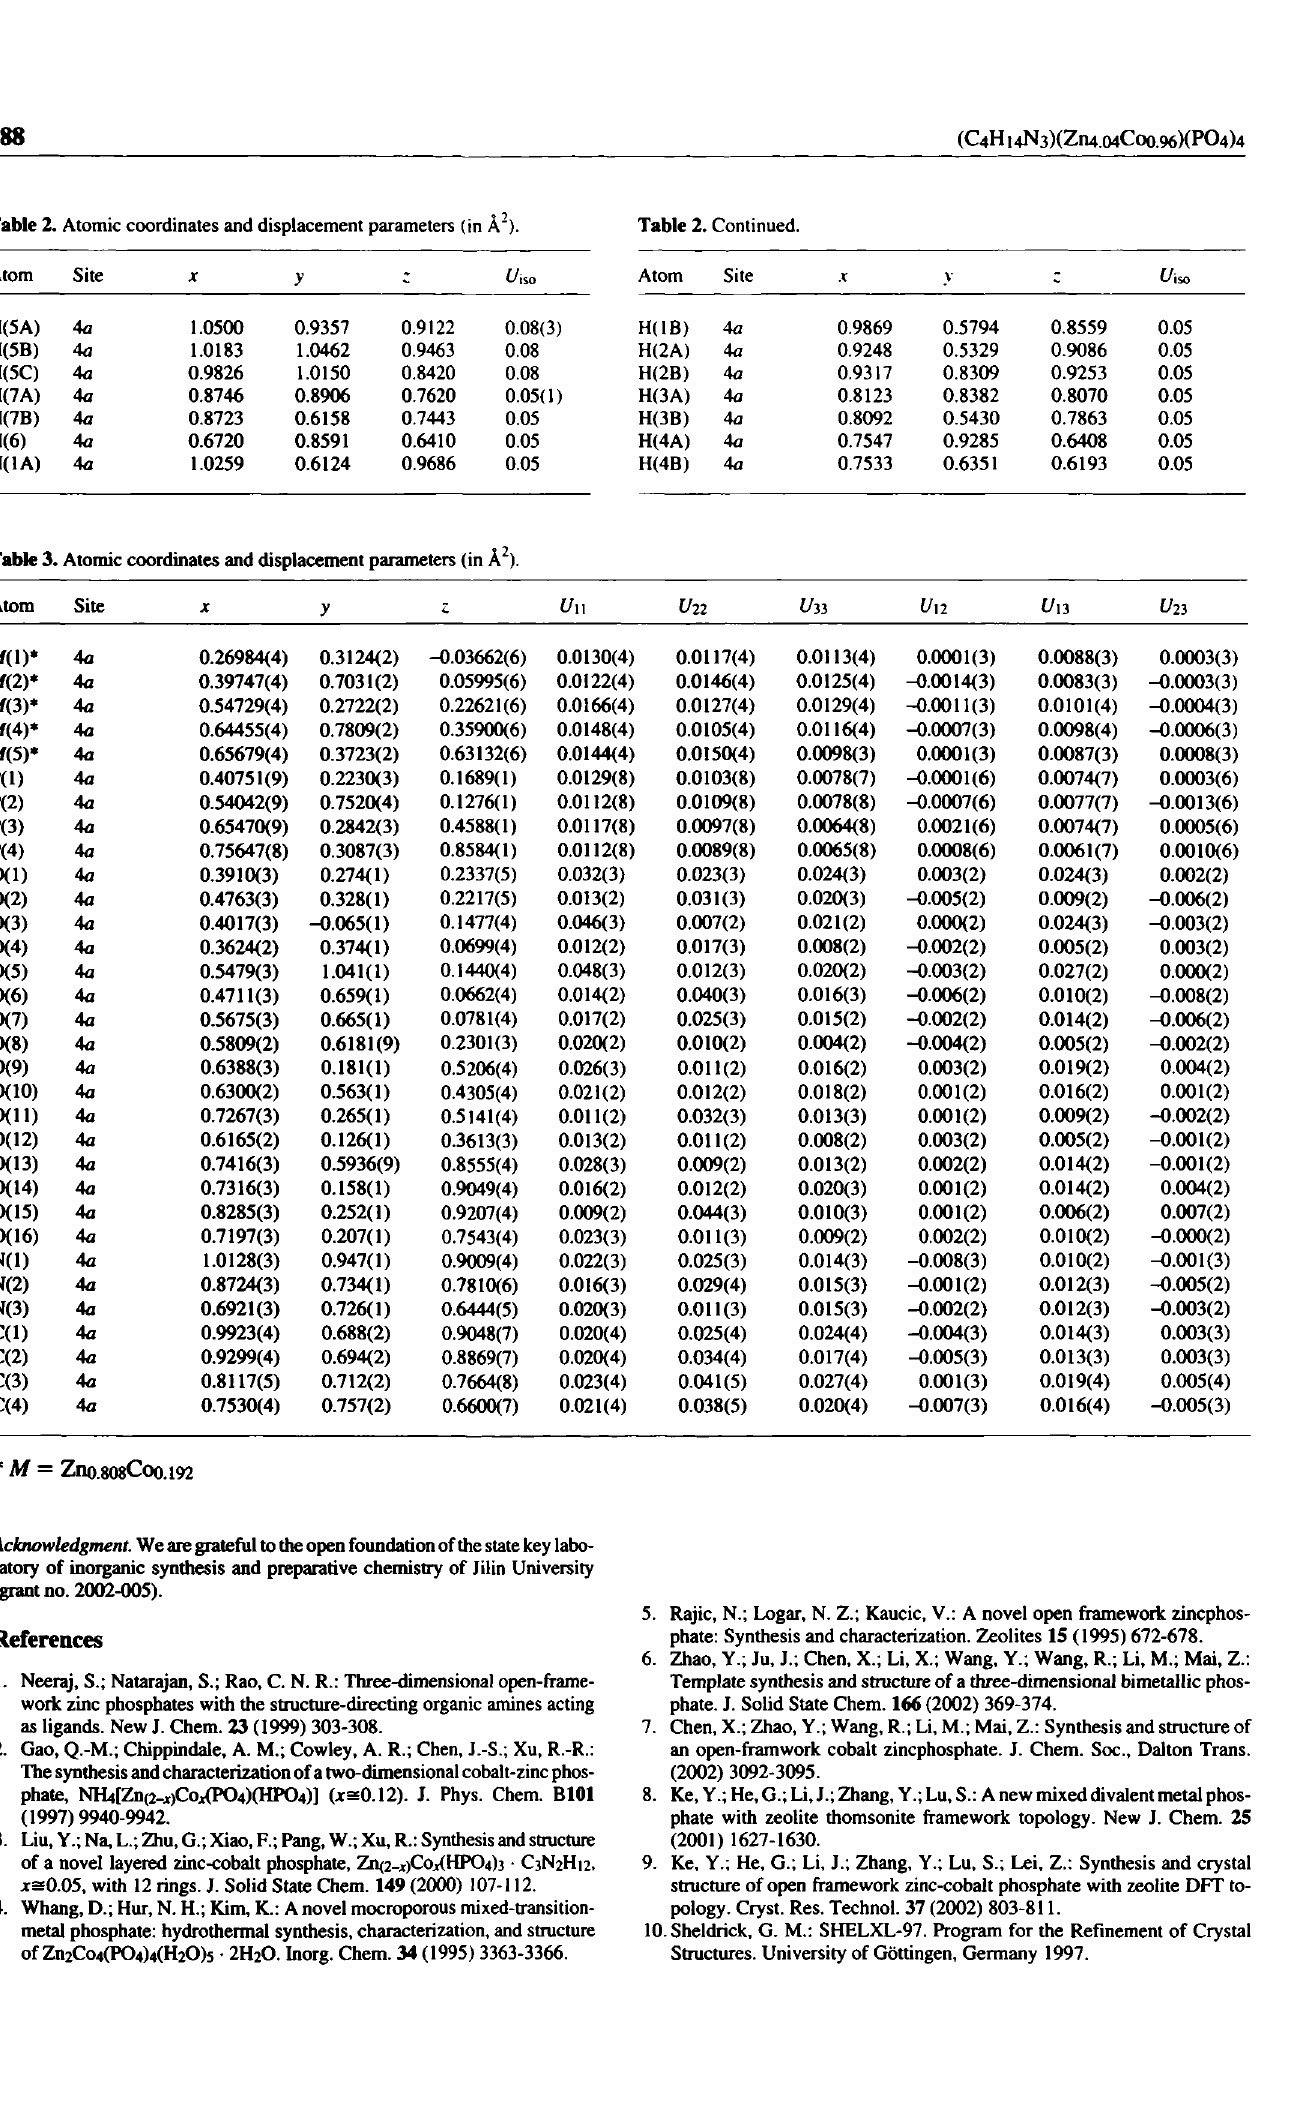
Table 3. Atomic coordinates and displacement parameters (in À 2